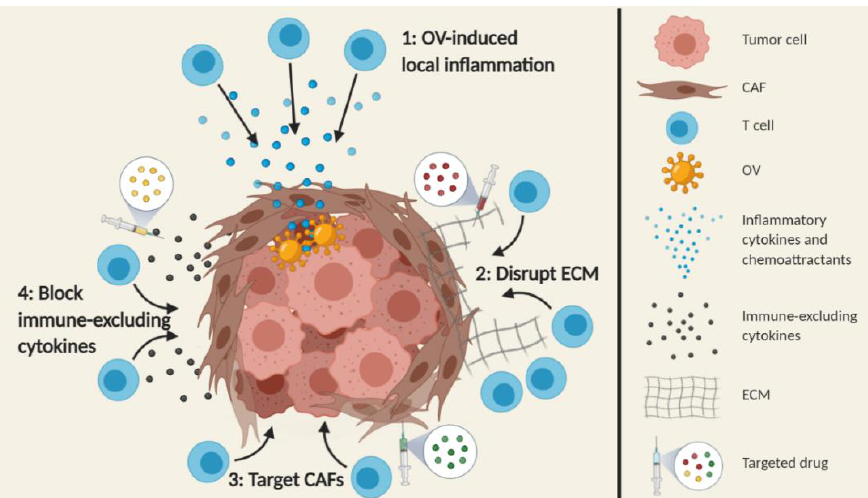
Figure 3. Solutions for hurdle 2: sparse T-cell infiltration. ( 1 ) Pre-treatment with OV generates a strong interferon response in the tumor, resulting in local innate and adaptive immune responses and strong T-cell infiltration. ( 2 ) Disruption of the physical extracellular matrix (ECM) barrier prevents T cells from getting stuck in the ECM and allows infiltration into the tumor nests. ( 3 ) Targeting cancer-associated fibroblasts (CAFs) removes the major producers of ECM components and immune-excluding cytokines, thereby improving T-cell infiltration. ( 4 ) Blockade of immune-excluding cytokines reduces limiting factors for T-cell infiltration, resulting in better infiltrated tumors.